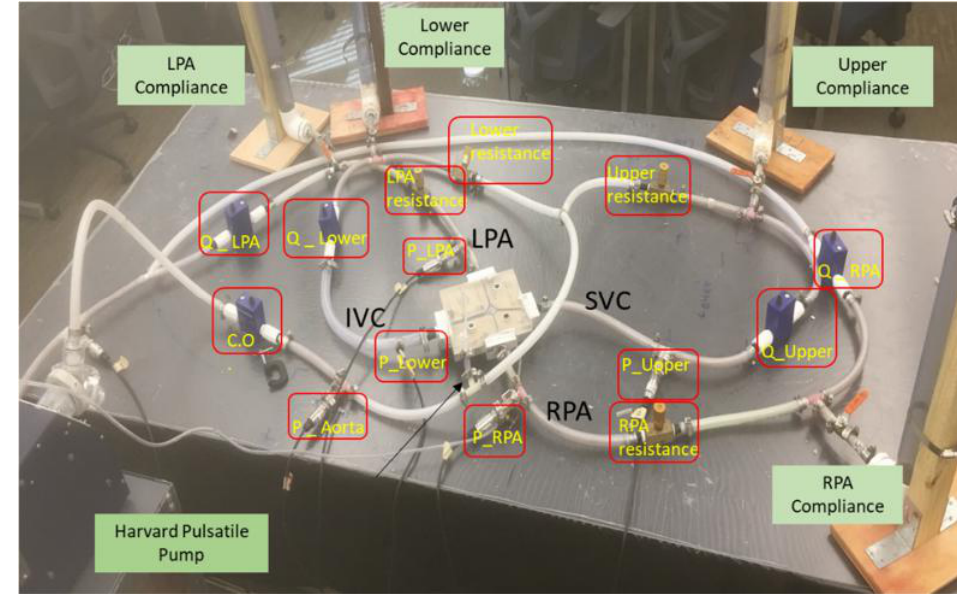
Figure 8. MFL setup for Fontan circulation with proposed injection shunt.